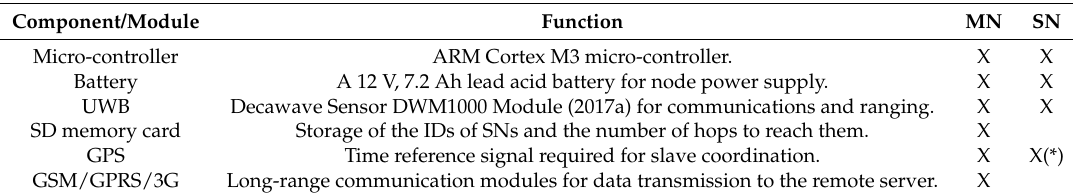
Table 1. Wi-GIM network nodes components and modules.